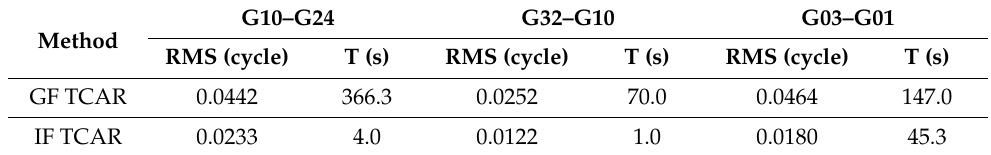
Table 5. The mean RMS and the convergence time of the GPS L1